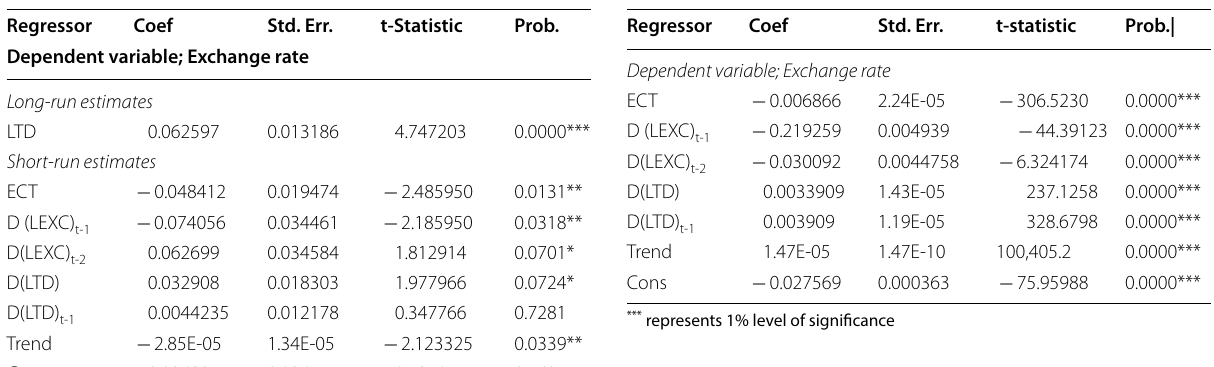
Table 6 Short-run estimates based on PMG for the United